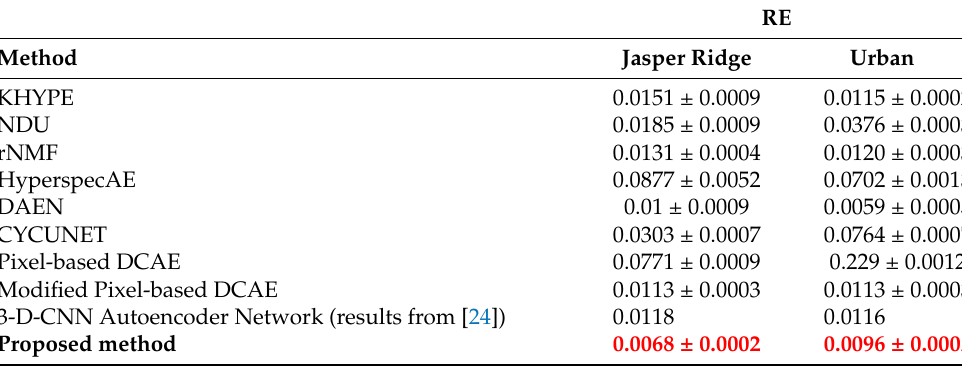
Figure 9. Maps of reconstruction error of the Jasper Ridge data. From upper left to right: VCA-K- Hype, N-FINDR-NDU, rNMF, DAEN. From bottom left to right: CYCUNET, Pixel-based DCAE, Modified Pixel-based DCAE, and the proposed method, respectively. Table 6. Re-comparison of the real airborne data (best results are highlighted in